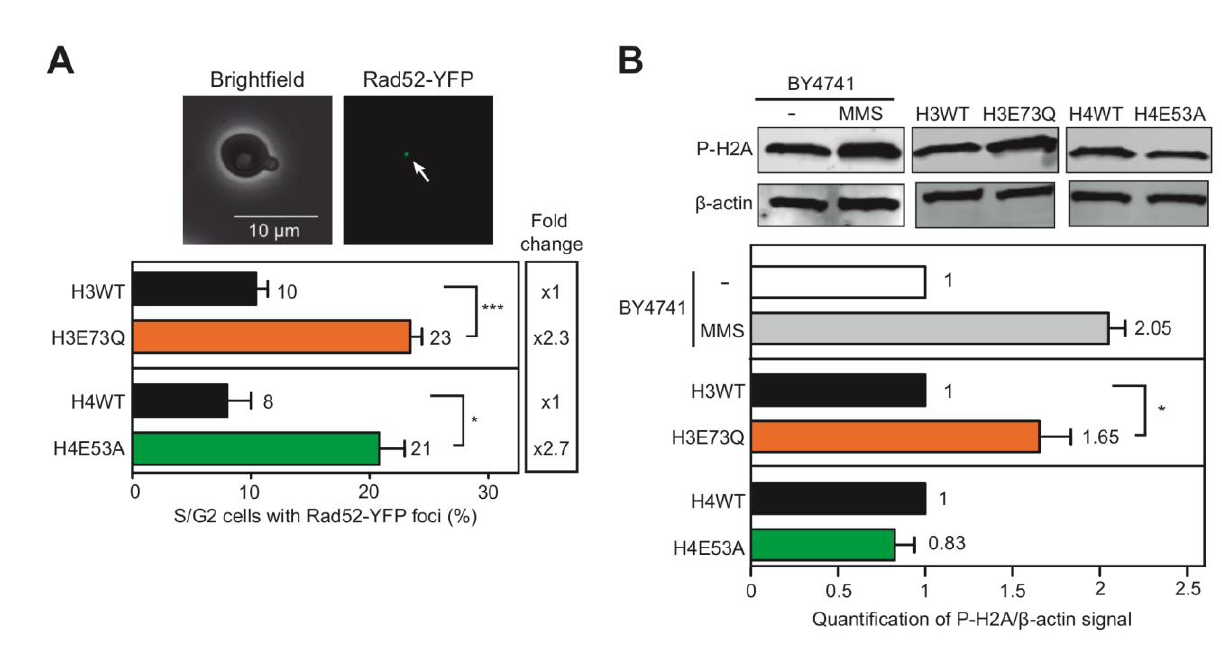
FIGURE 2: Histone H3E73Q or H4E53A mutants increase DNA damage. (A) Analysis of the percentage of S/G2 cells containing Rad52-YFP foci in H3 wild-type (H3WT), H3E73Q (H3E73Q) , H4 wild-type (H4WT) and H4E53A (H4E53A) strains transformed with pWJ1344. A repre- sentative image of a cell with a Rad52-YFP focus is shown (n = 3). (B) Accumulation and quantification of the immunofluorescence signal of P- H2A in H3 wild-type (H3WT), H3E73Q (H3E73Q) , H4 wild-type (H4WT) and H4E53A (H4E53A) strains detected by fluorescence-based western blot (n = 3). A representative fluorescence-based western blot and the BY4741 strain treated with 0.05% MMS for 1.5 hours as a control (n = 2) is shown. Actin is shown as the loading control. Means and SEM are plotted in all panels. *p ≤ 0.05, ***p ≤ 0.001 (two - tailed Student’s